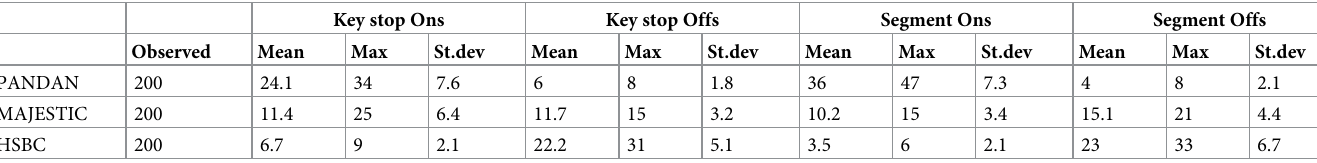
Table 4. Route U32 passenger activity statistics summary; AM peak,